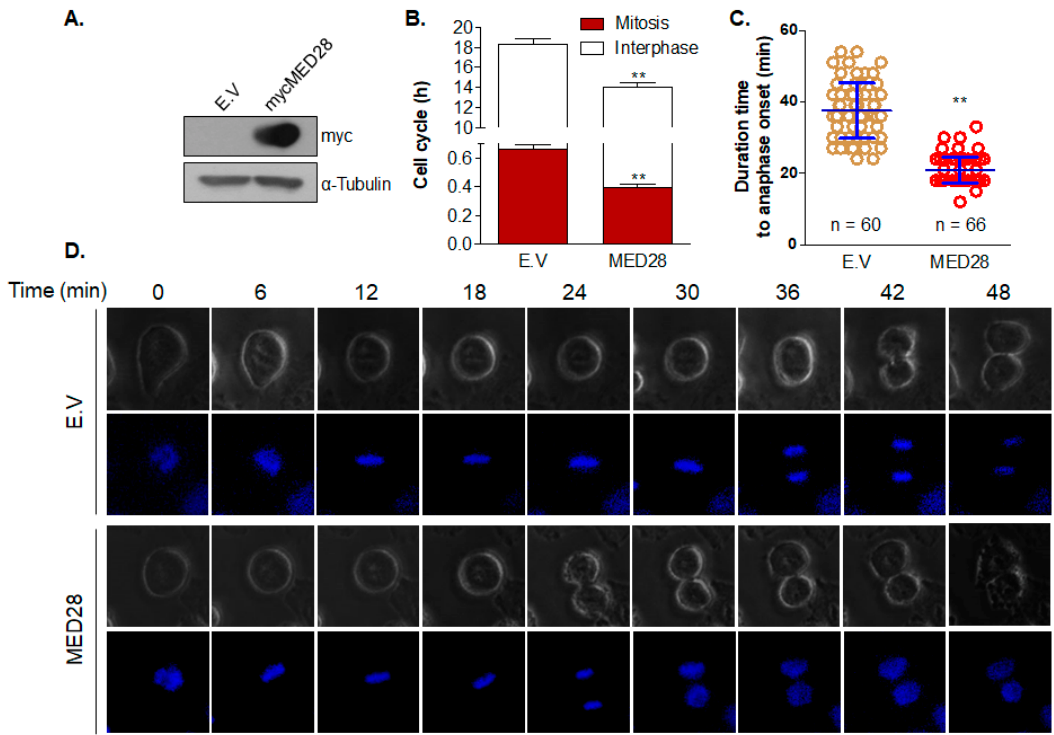
Figure 3. MED28 overexpression promotes cell division. ( A ) After transfection of the control Myc-expressing vector (empty vector; E.V.) or the Myc-MED28 plasmid into HeLa cells, a stable cell line was selected with G418 as described in the Materials and Methods section. MED28 expression was confirmed by western blotting. MED28 was detected with an anti-Myc antibody. Tubulin was used as a loading control. ( B ) The whole cell cycle duration was investigated using time-lapse photomicroscopy as described in the Materials and Methods section. At least 60 cells per sample were counted per experiment, and the results from at least three independent experiments are presented (**, vs. E.V.). ( C , D ) HeLa cells harboring control E.V. or stably expressing MED28 were cultured and stained with Hoechst. The period from prophase to anaphase onset, defined as chromosome separation, was measured. The cells were imaged by a time-lapse photomicroscopy during mitotic progression under 60 × magnification. Photos were taken every 3 min, and the start time was set to the nuclear envelope breakdown (**, vs. E.V.). ** p < 0.01.